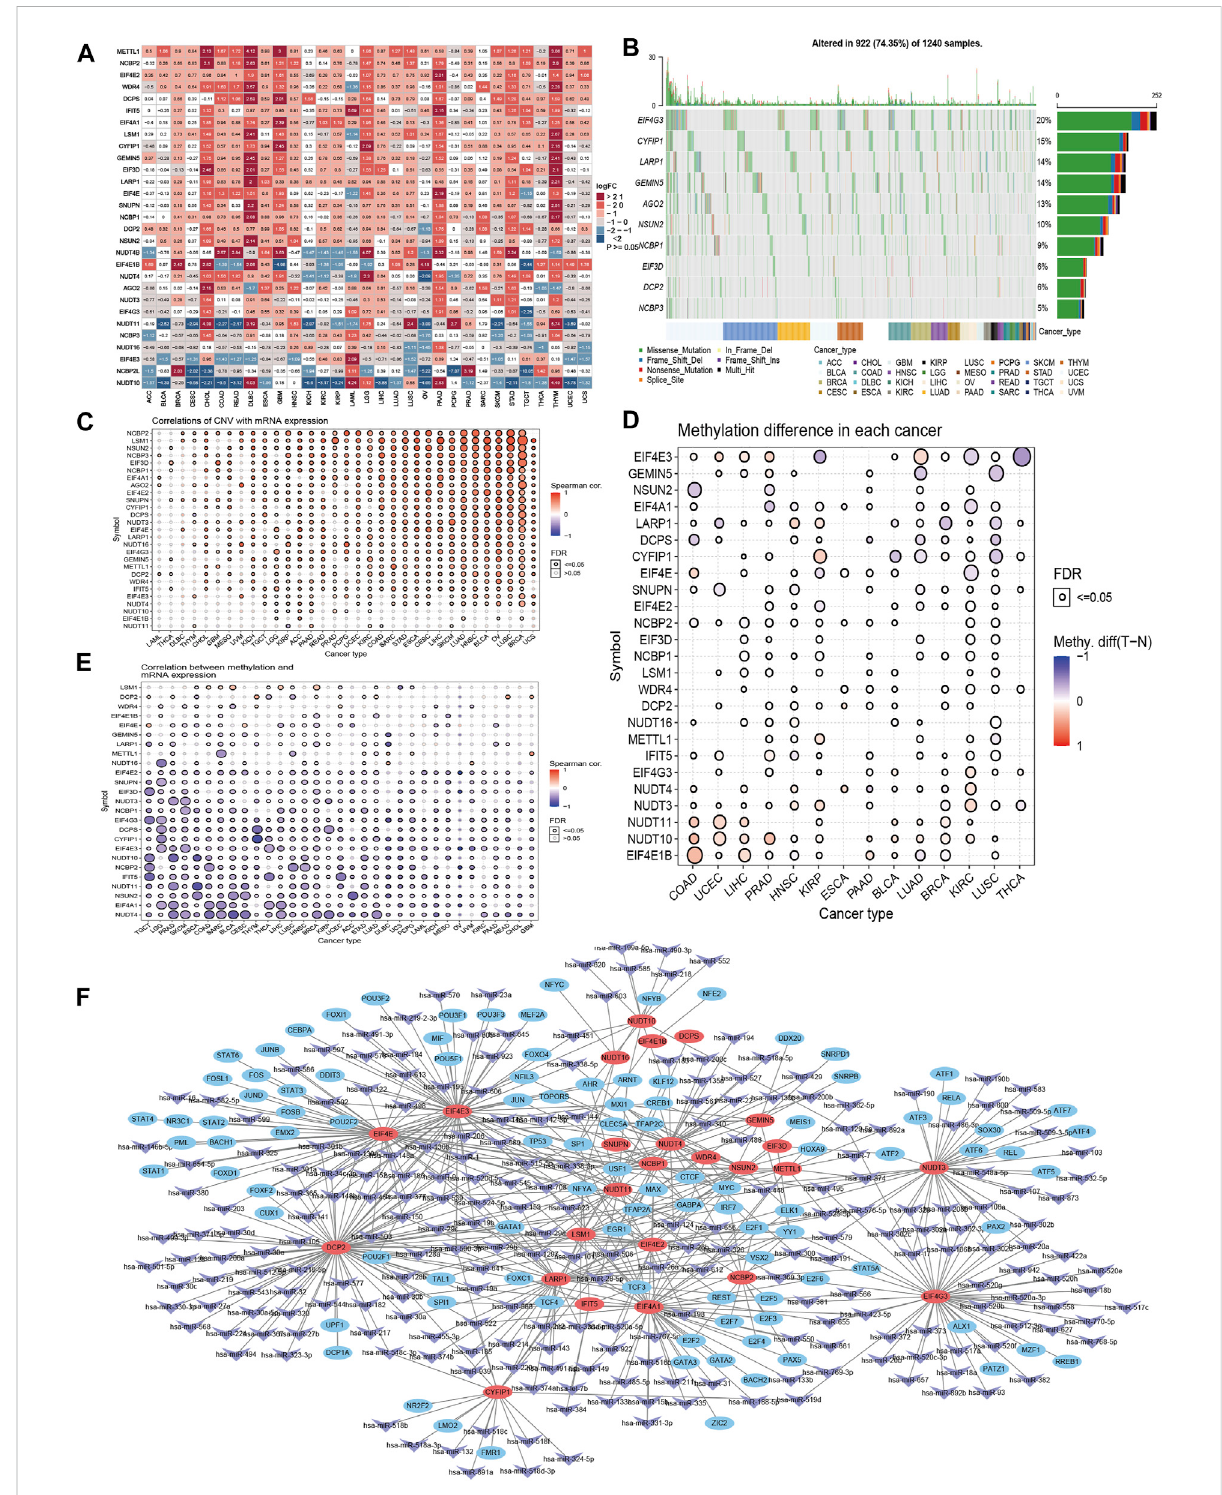
FIGURE 1 Geneticalterationportfolioofm7GRNAmodi fi cation-relatedregulatorgenesincancers. (A) Differentialexpressionof29m7Grelatedregulator genes in 33 cancers. (B) Summary of top 10 gene variations in selected cancers. (C) Correlation of regulator gene expression and CNV. (D) Methylation level of regulator genes varied in each cancer. (E) Correlation of regulator gene expression and methylation level. (F) Network of predictive miRNAs and transcription factors mediated in regulation of m7G related regulator